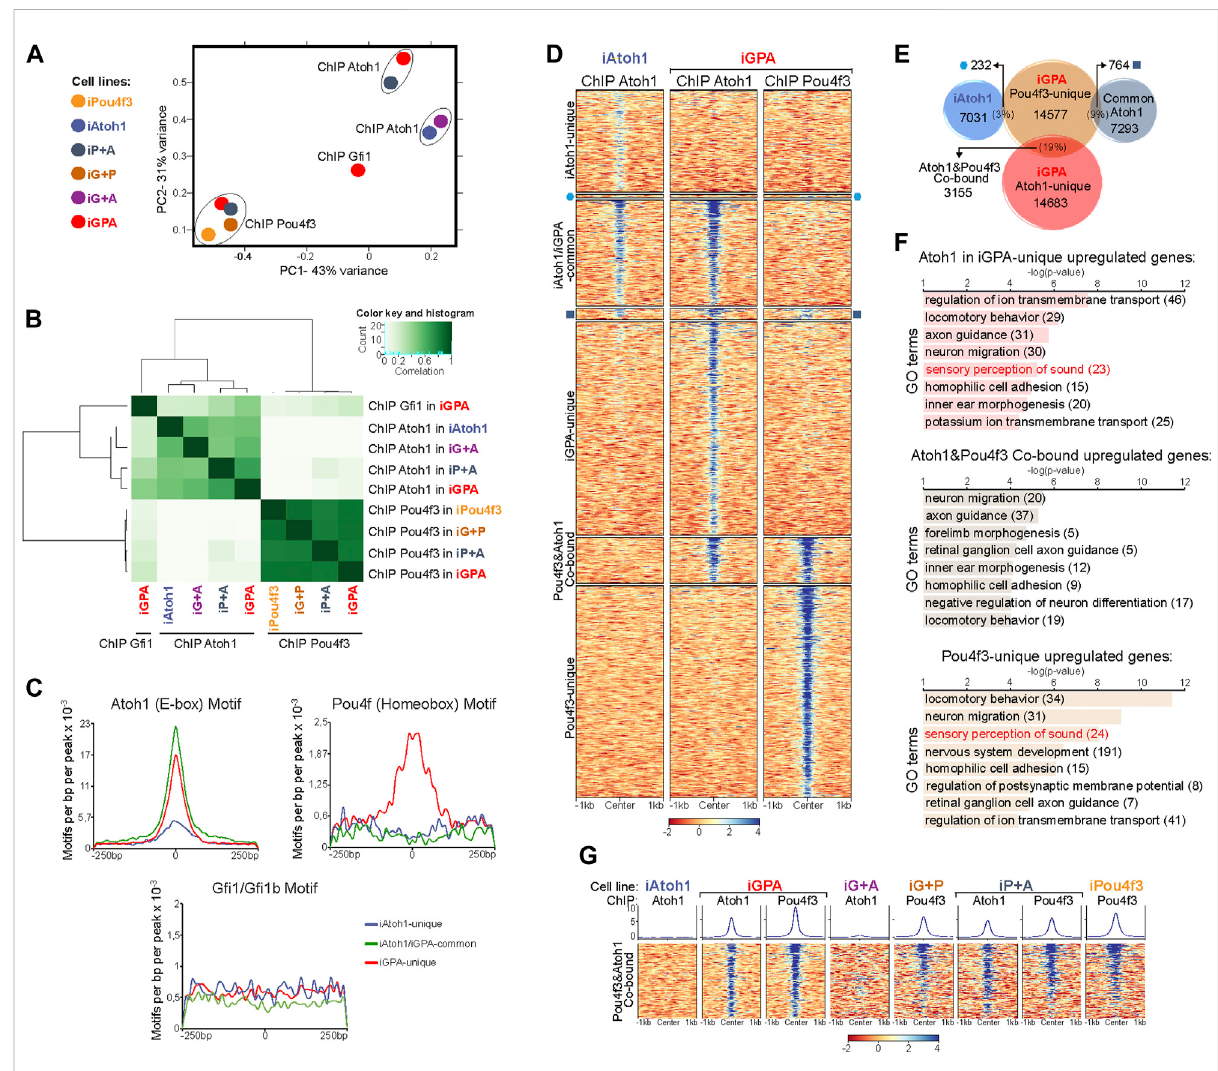
Pou4f3 recruits Atoh1 to new binding locations but not vice versa . (A) Principal component analysis of Atoh1, Pou4f3 and G fi 1 ChIP-seq peaks for each EB overexpressing combinations of the three TFs (48 h post-Dox treatment) as indicated by the colour key. G fi 1 ChIP-seq was only performed in iGPA EBs but ChIP-seq for Atoh1 and Pou4f3 was carry out in EBs overexpressing all 4 possible TF combinations. (B) Correlation heatmapofAtoh1,Pou4f3,andG fi 1ChIP-seqpeaksforeachEBoverexpressingcombinationsofthethreeTFs. (C) Frequencyanddistributionof Ebox, Pou4f homeobox and G fi 1 motifs across a 250 bp interval surrounding the Atoh1 peak centres for each Atoh1 peak group identi fi ed in (Figure4A) (D) DensityheatmapsofAtoh1Chip-seqobtained fromiAtoh1andiGPAEBsandPou4f3ChIP-seqfromiGPAEBs.Theheatmapisdivided inseven parts containingthe overlapping and non-overlapping peaks across the3ChIP-seq datasets as represented in (E) . (E) Peak overlap between Pou4f3ChIP-seqiniGPAEBsandAtoh1ChIP-seqinbothiAtoh1andiGPAEBs.Thenumberofuniqueandoverlappingpeaksacrossthese3ChIP-seq datasetsisindicatedinthediagramandtheirChIPsignalisshownin (D) . (F) Geneontology(GO)analysisperformedforuniqueandcommonpeaksof Atoh1/Pou4f3 ChIP-seq in iGPA EBs that were only associated with differentially expressed genes found in iGPA RNA-seq. Peaks were associated with genes following the nearest gene annotation rule. (G) Density heatmaps of Atoh1 and Pou4f3 ChIP-seq enrichment only at Atoh&1Pou4f3 cobound peaks (3,155 genomic regions) in different induced EBs. Peak signal (in colour scales) represents the normalized counts (reads per kilobase per million, RPKM) and is spanning ± 1 kb from the centre of the